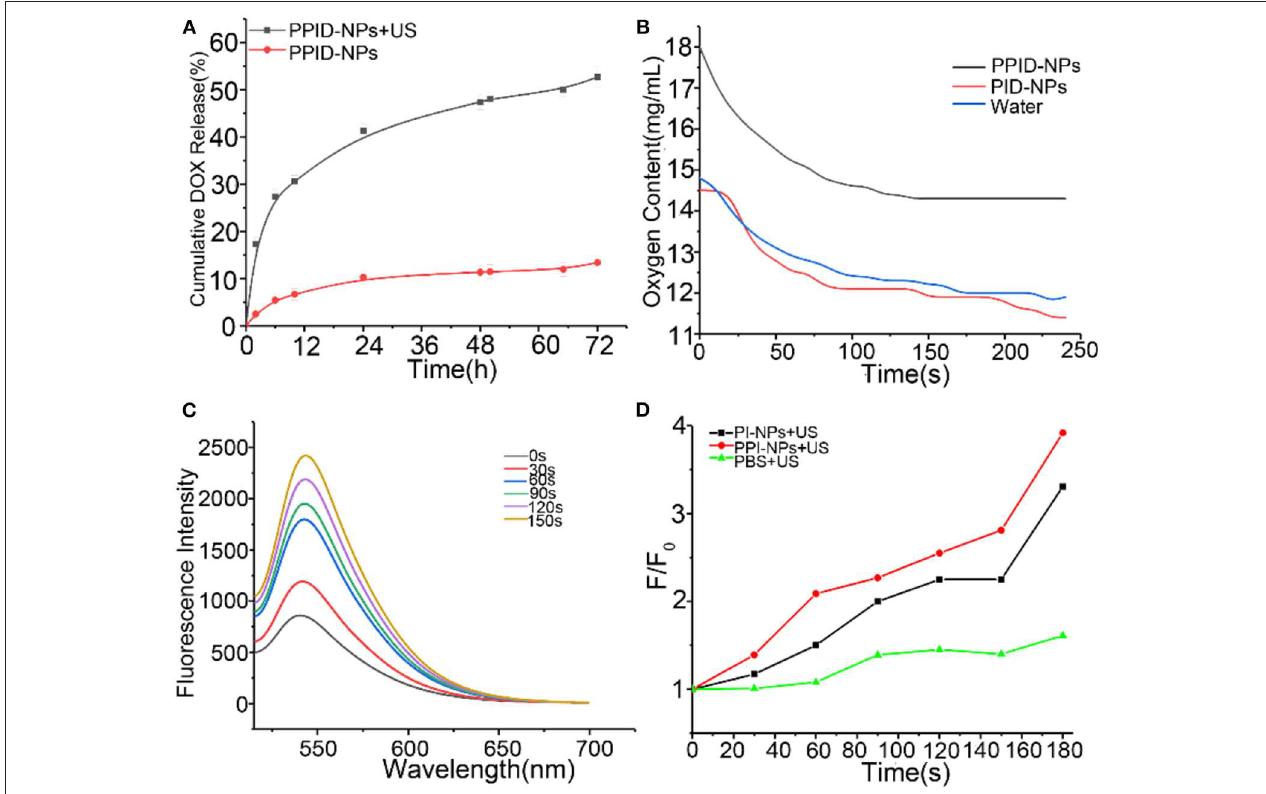
FIGURE 3 | (A) After 72h, DOX release from PPID-NPs with or without US irradiation (1 MHz, 1.0 W/cm 2 ). (B) Oxygen content of water and PPID-NPs. (C) Time-dependent 1 O 2 generation of PPI-NPs as irradiated by US (1 MHz, 1.0 W/cm 2 ). The concentration of IR780 was 21.6 µ g/mL. (D) The time-dependent fluorescence increment of SOSG under ultrasound irradiation.